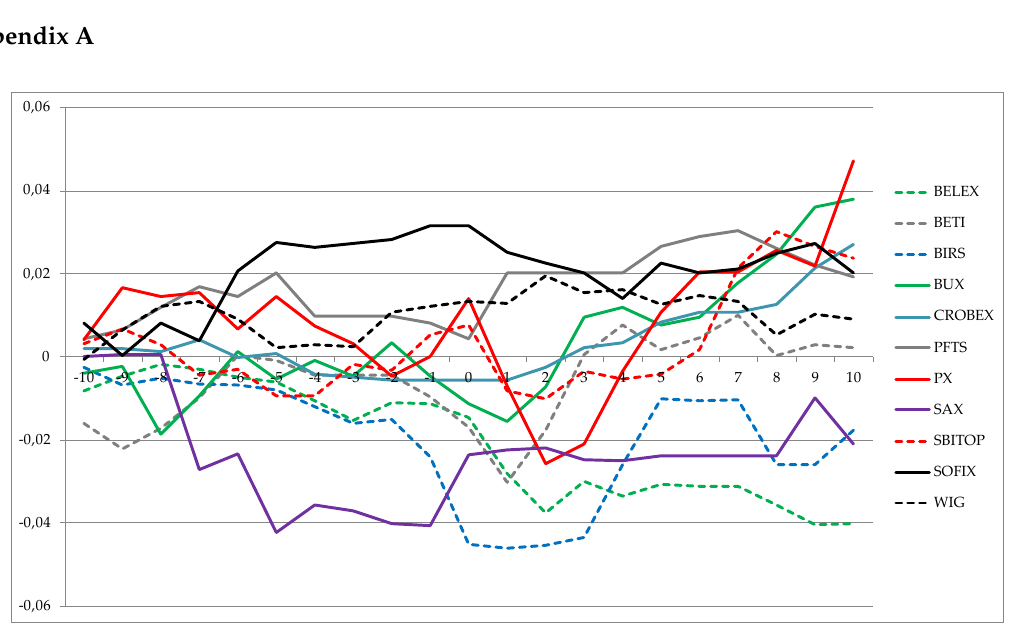
Figure A2. Individual CAR s, SEE regional market factor. Table A1. Descriptive statistics for return series. Return